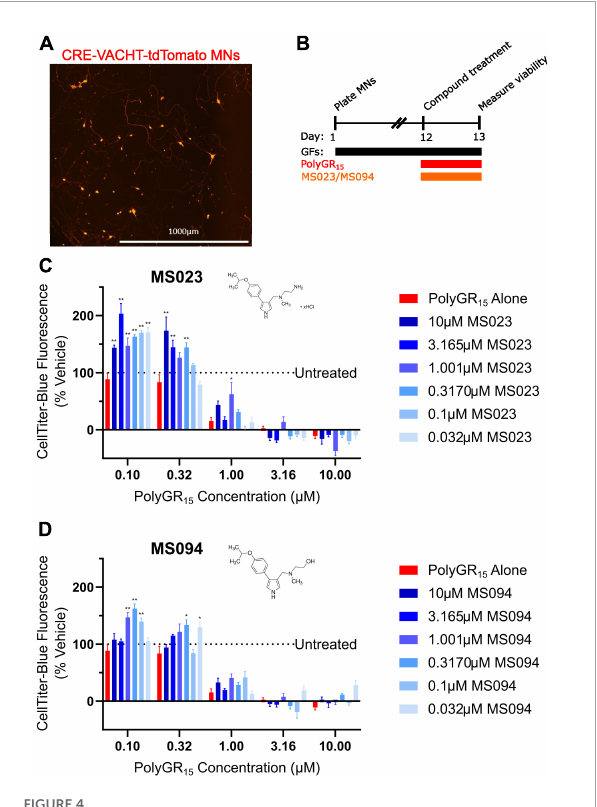
FIGURE4 Protein arginine methyltransferase inhibition improves induced pluripotent stem cell (iPSC)-motor neuron (MN) survival in response to polyGR 15 challenge. (A) Representative image of tdTomato + CRE-VACHT-tdTomato control motor neurons employed in polyGR 15 –PRMT inhibitor cross-titration. (B) Timeline for cross-titration experiment. Neurons were differentiated to spinal motor neurons, and on day 1, dissociated and plated into 384-well plates. After 12 days, neurons were treated with polyGR 15 concentrations ranging from 100 nM to 10 µ M, and co-treated with MS023 or MS094 concentrations ranging from 32 nM to 10 µ M. Cell survival was measured 24 or 48 h after treatment. (C) Neuronal survival following polyGR 15 co-treated with MS023 normalized to vehicle treated wells (0.2% DMSO). (D) Neuronal survival following polyGR 15 co-treated with MS023 normalized to vehicle treated wells (0.2% DMSO). *Denotes p < 0.05, and **denotes p < 0.01 (comparing MS023 or MS094 co-treated groups to polyGR 15 alone by one-way ANOVA analysis of variance followed by Dunnett’s test). Data are presented as mean values ± standard deviations (error